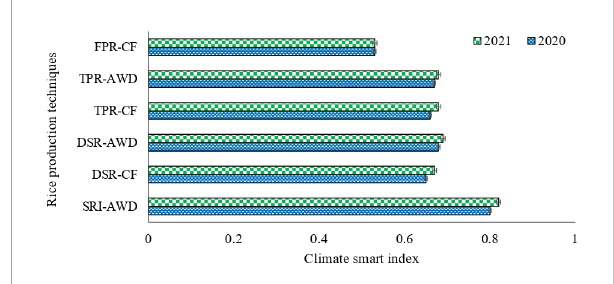
FIGURE 5 Climate smartness index (CSI) during both the season under different rice production techniques in rice